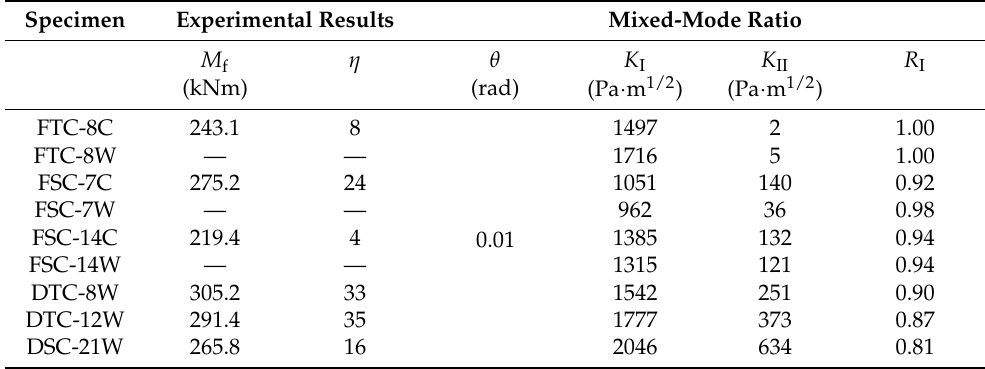
Table 6. Mixed-mode ratios for each specimen.